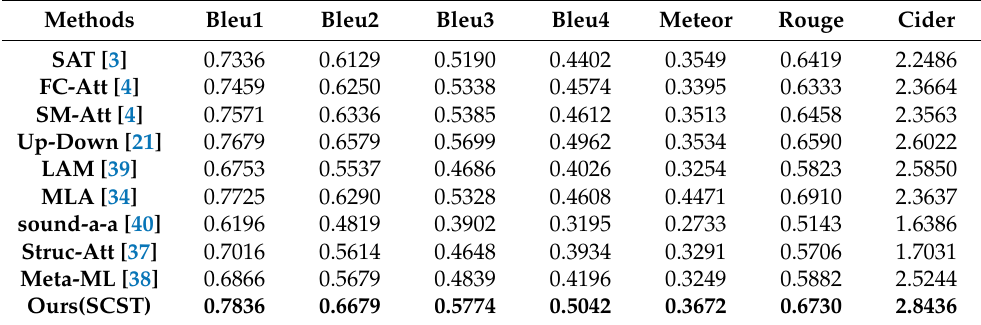
Table 3. Comparison of scores for our method and other state-of-the-art methods on the RSICD data set